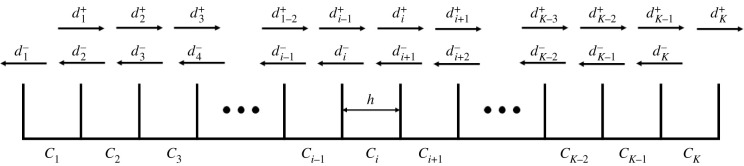
Schematic illustrating the jump rates, di±, between compartments when simulating the mesoscopic reaction–diffusion paradigm on the domain [a, b] with compartment size h.